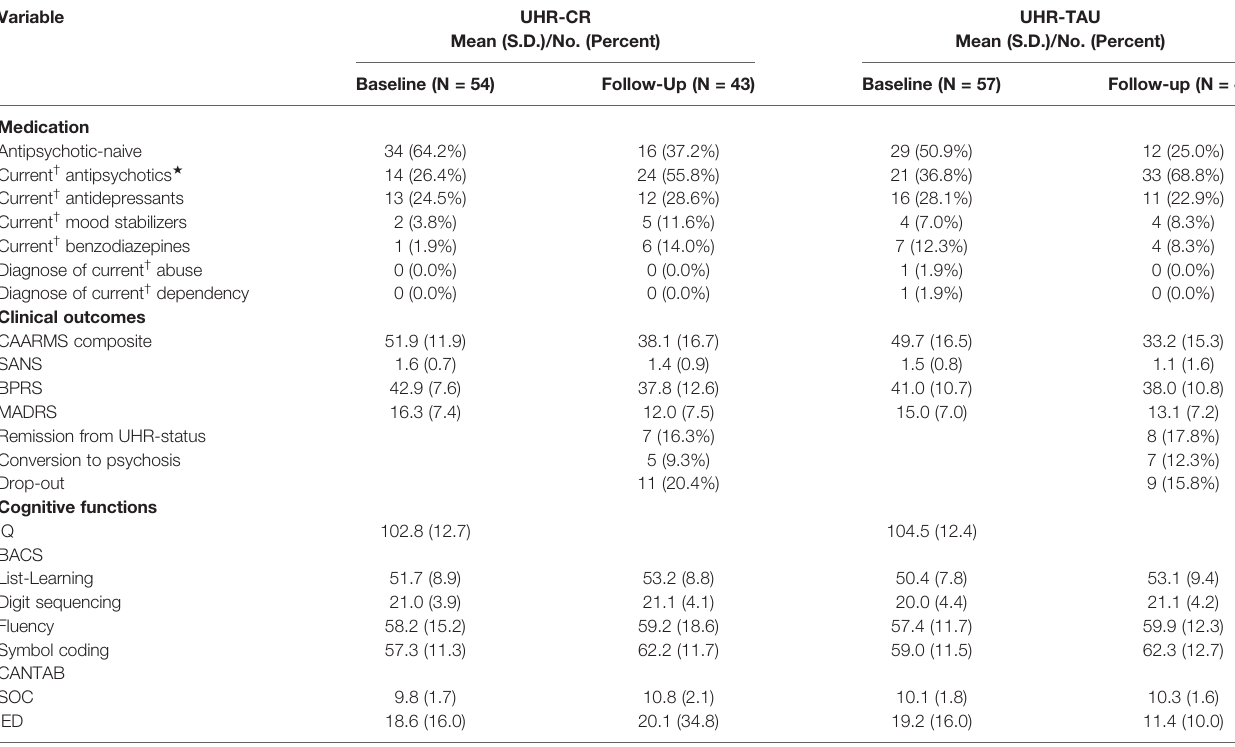
TABLE 2 | Clinical and cognitive data at baseline and follow-up for UHR individuals.